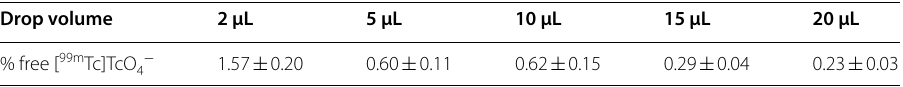
Each experiment was carried out in triplicate (n